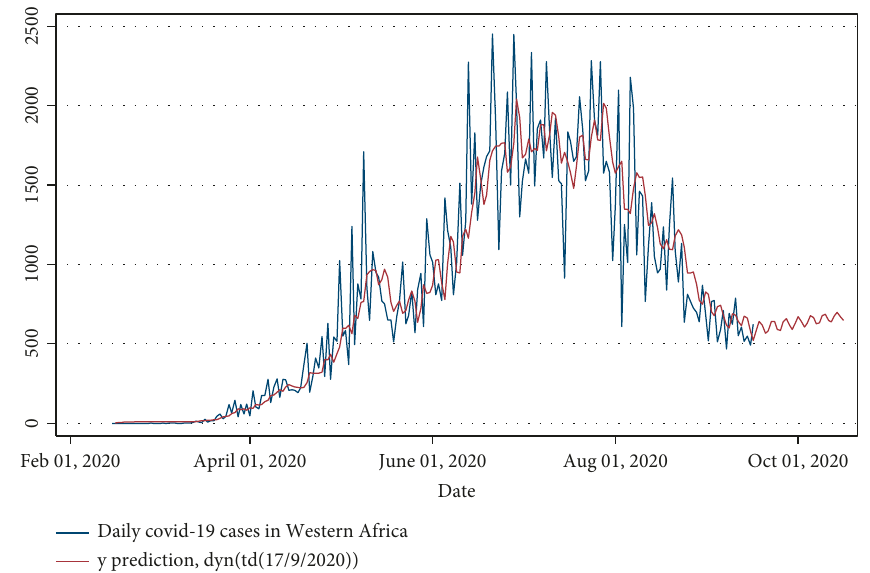
Figure 5: The plot of actual confirmed cases with the prediction result of the ARIMA model for West Africa.